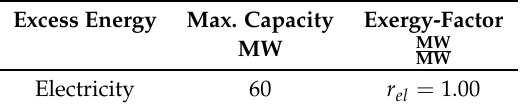
Table 2. Excess energy: grid connection capacities and exergy factors.